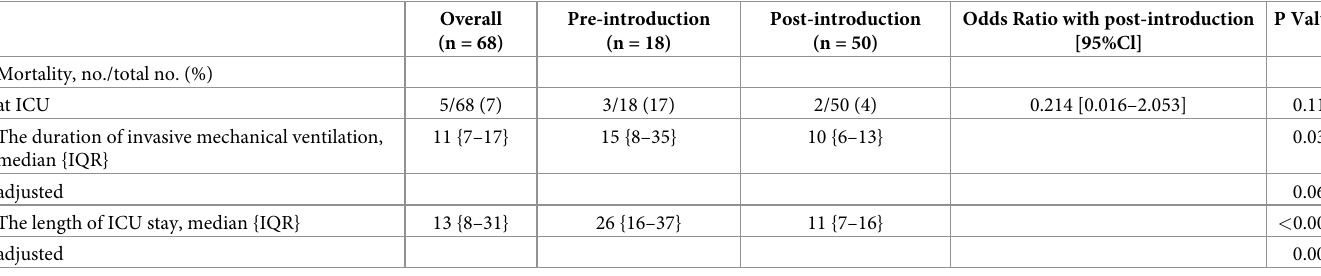
Table 3. Primary and secondary